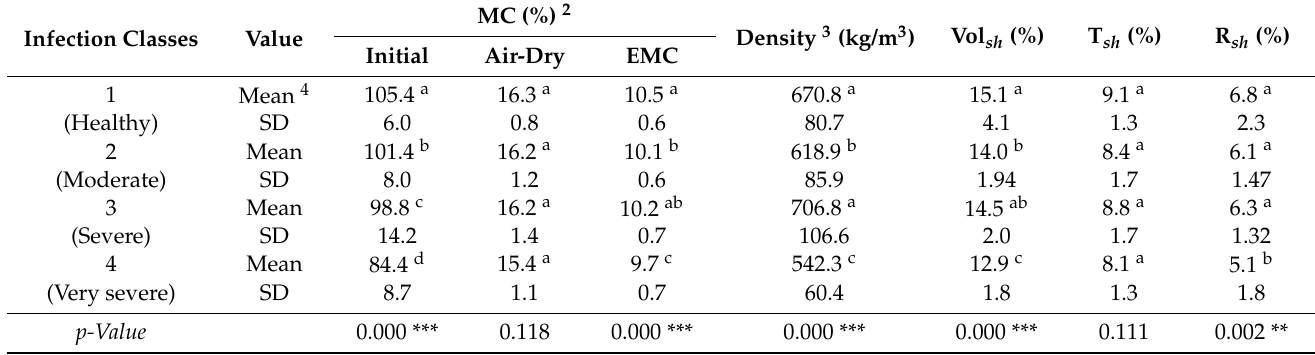
Table 4. Effects of infection by Crysoporthe deuterocubensis on physical properties of Eucalyptus urograndis lumbers 1